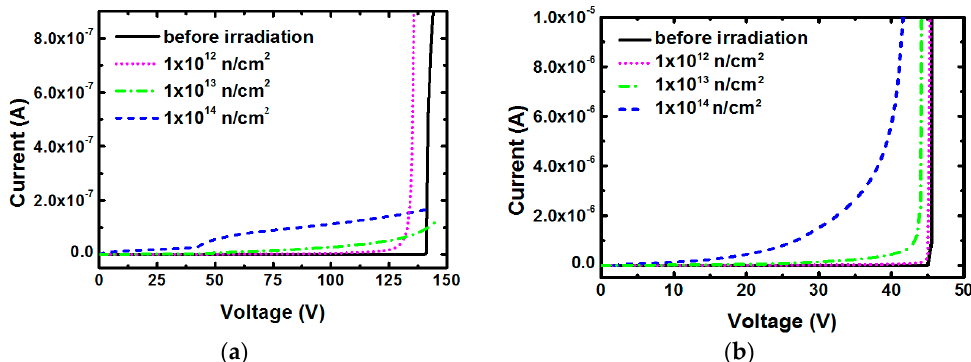
Figure 2. Reverse dark I-V characteristic of the ( a ) Si-based APDs and ( b ) InP-based APDs before and after neutron irradiation. and after neutron